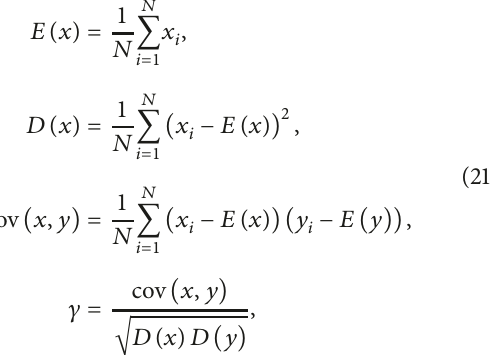
Table 2: The IE of the testing